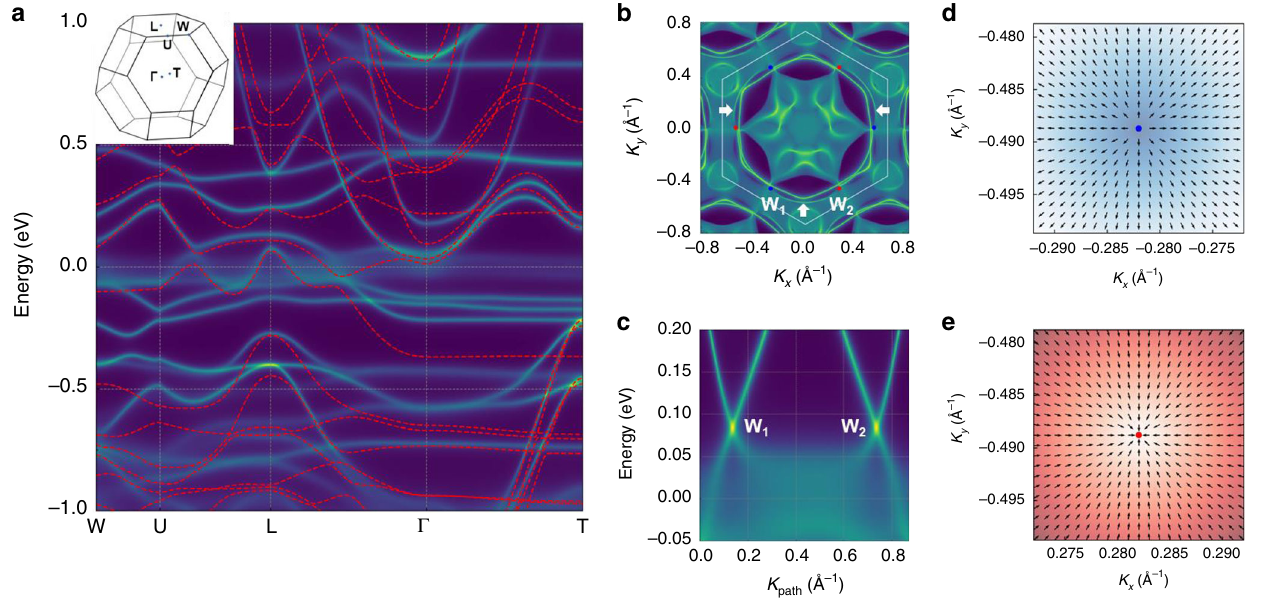
Fig. 3 Many-body-calculation-derived electronic structure of ferromagnetic Co 3 Sn 2 S 2 . a Momentum-resolved electronic spectra and single-particle band-structure along the high-symmetry lines of the bulk Brillouin zone (the upleft inset). The momentum-resolved electronic spectra are in bright yellow color. The single-particle band-structure is represented by the red dashed curves. b Fermi arcs on the (001) surface. The blue and red dots, W 1 and W 2 , represent the projected Weyl points with positive and negative chirality, respectively. The three white arrows indicate the Fermi arcs. c Bulk Weyl cones along the direction connecting the Weyl points W 1 and W 2 in b . Distribution of the Berry curvature around the Weyl points W 1 ( d ) and W 2 ( e ) in the k xy